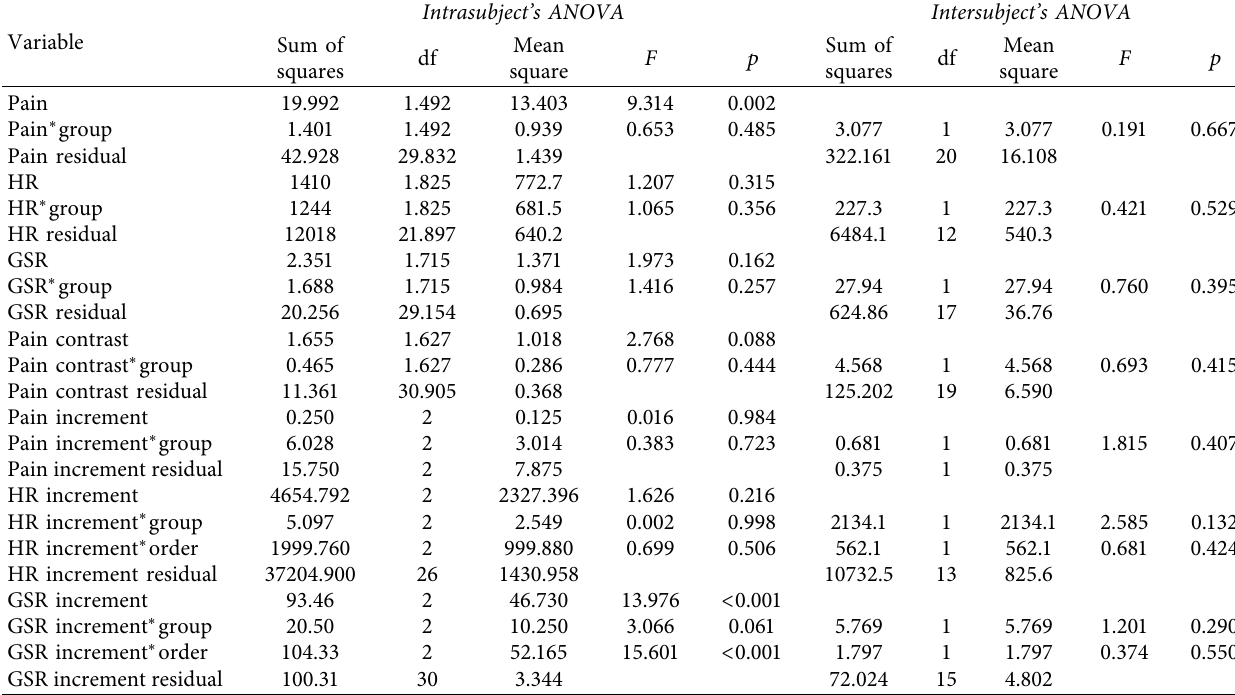
Table 5: ANOVA statistics of the variables.